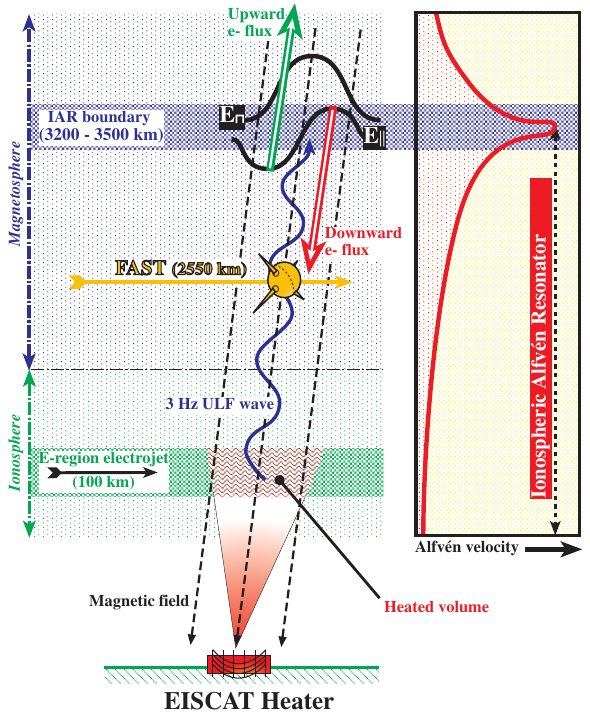
Fig. 1. Schematic showing the EISCAT heater modulating the con- ductivity in the E-region ionosphere where naturally occurring cur- rents such as the electrojet are modulated by the heating modulation frequency of 3Hz. This launches a 3Hz ULF wave along the geo- magnetic field lines that is detected directly by the FAST satellite. At the IAR the wave acquires a significant parallel electric field, which accelerates the downward moving electrons that are detected by FAST at each edge of the wave propagation region (after Robin- son et al. 2000).